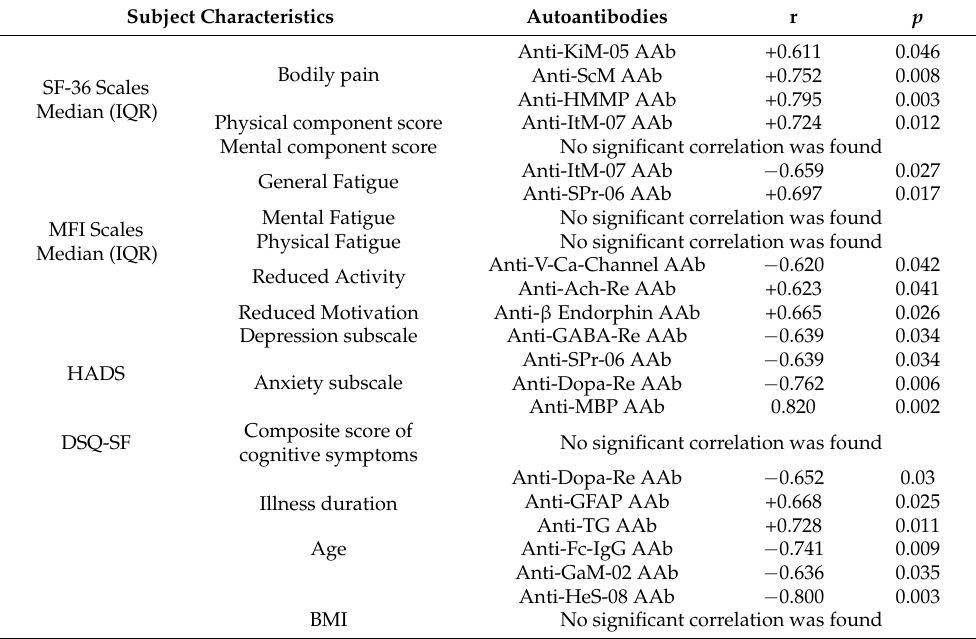
Table 5. Clinical correlations of the absolute AAb deviations from AIR in the group of patients suffering from ME/CFS without comorbid FM. (Spearman correlation coefficient r and p -value).